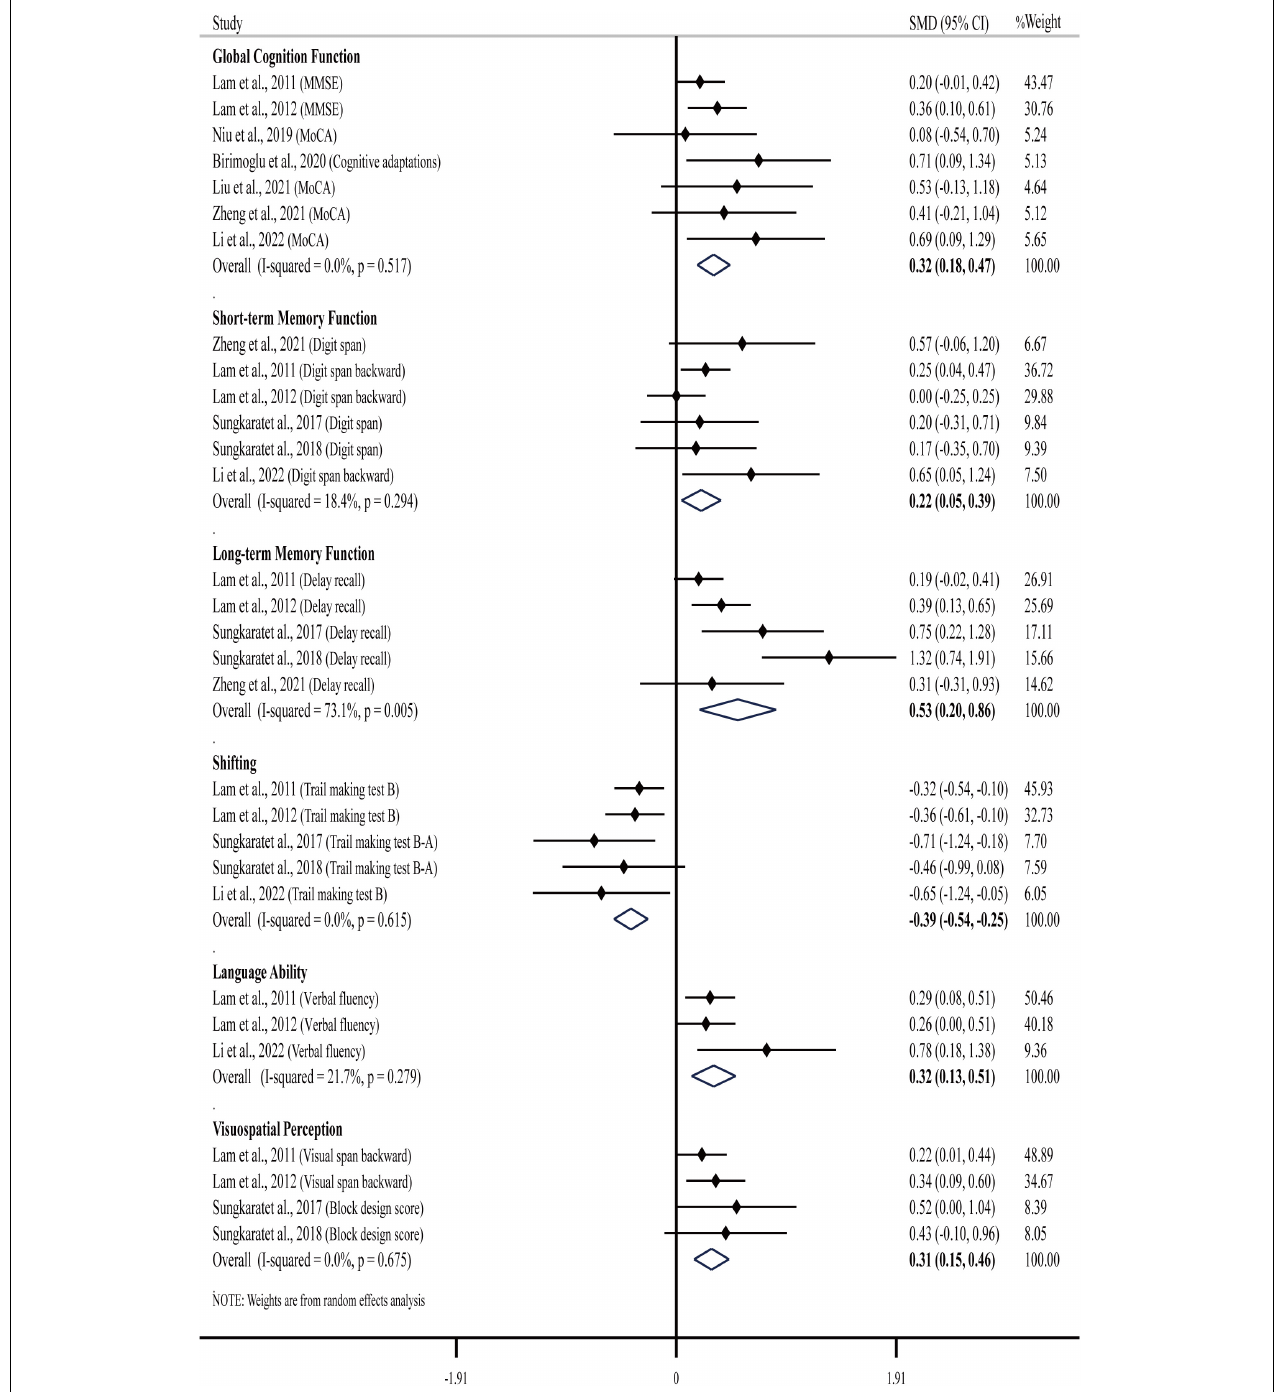
FIGURE 3 | Overall analysis results regarding the effects of TCEs on global cognition function and specific cognitive domains.